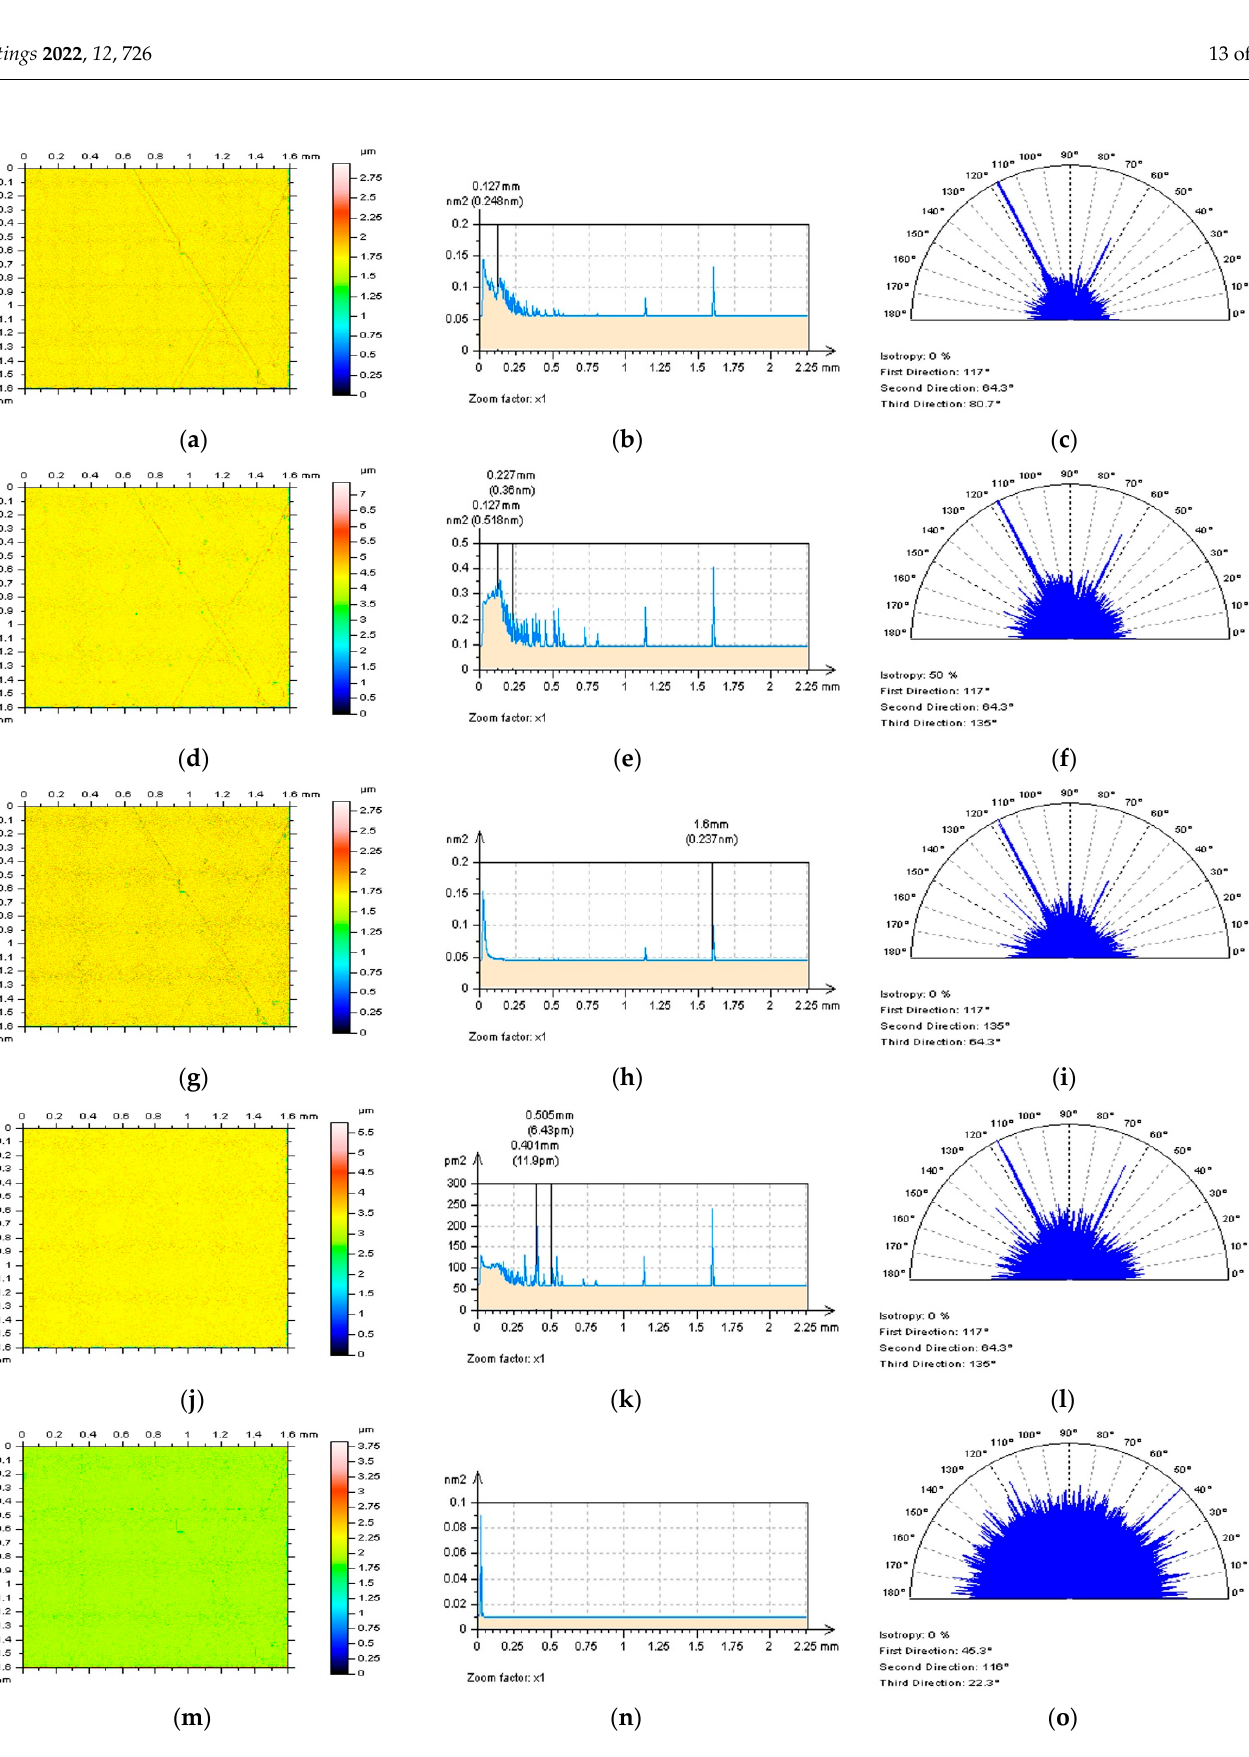
Figure 7. Analysis of a HFNS (left column), their PSDs (middle) and TDs (right column) received from a plateau-honed cylinder surface containing oil pockets by usage of: GF ( a – c ), RGF ( d – f ), SF ( g – i ), MDF ( j – l ) and FFTF ( m – o ) approach, cut–off = 0.015 mm.